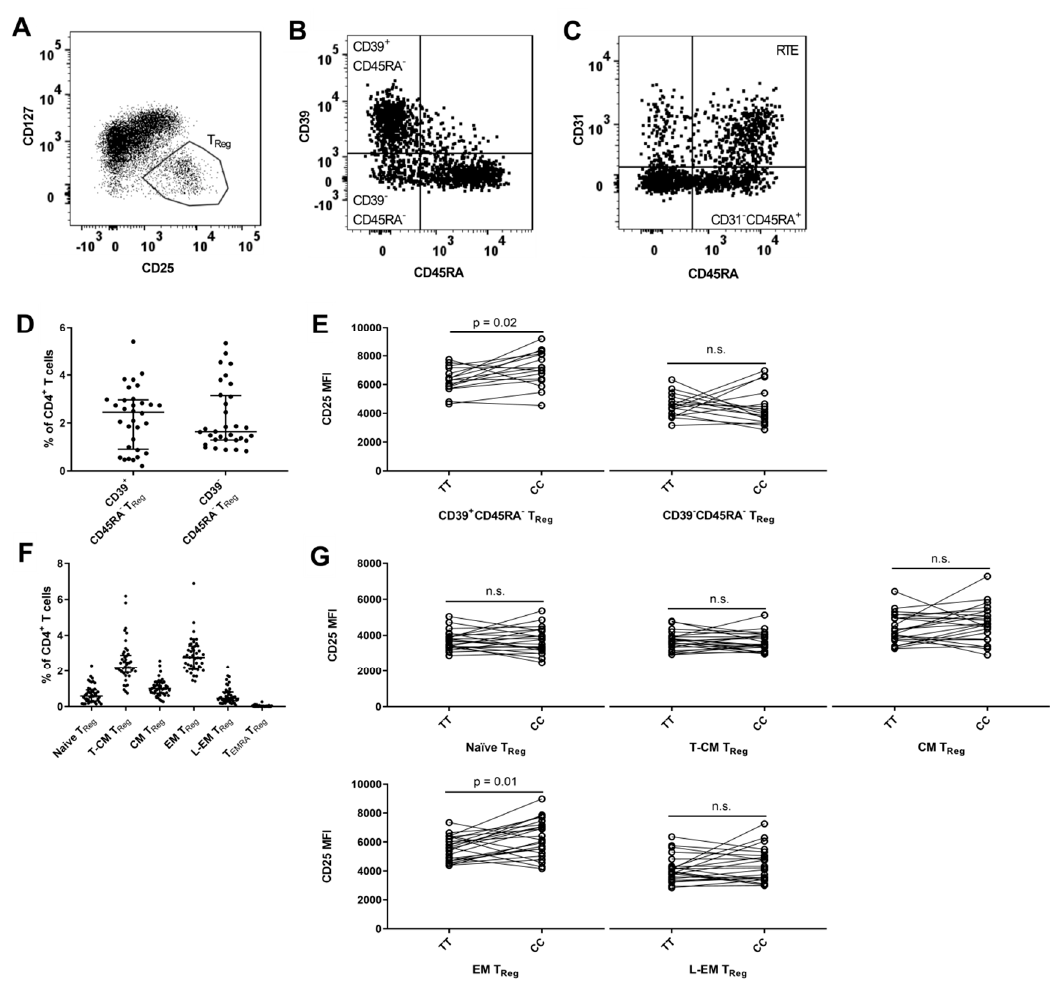
Figure 6. IL2RA genotype associations on CD4 + T Reg subsets. ( A ) Gating of T Reg cells, defined by being CD127 lo CD25 hi . ( B ) T Reg cells are gated by expression of CD39 and CD45RA in two subsets: CD39 + CD45RA − (committed T Reg cells) and CD39 − CD45RA − . ( C ) T Reg cells are gated by expression of CD31 and CD45RA in two subsets: Recent thymic emigrants (RTE; CD31 + CD45RA + ) and CD31 − CD45RA + . ( D ) Frequency of CD39 + CD45RA − and CD39 − CD45RA − T Reg in relation to CD4 + T cells. ( E ) Homozygous carriers of both MS-associated IL2RA SNPs rs2104286 and rs11256593 are defined by TT for the risk genotype and CC for the protective genotype. Di ff erences between carriers of the risk genotype TT (N = 16) and carriers of the protective genotype CC (N = 16) on surface expression of CD25 (MFI) on CD39 + CD45RA − (Paired t test, mean of di ff erence = 800.9; 95% CI = 175.2 to 1427) and CD39 − CD45RA − T Reg (Paired t test, mean of di ff erence = − 110; 95% CI = − 956.9 to 736.9) cells. ( F ) Frequency of naïve (CD45RA hi CCR7 + ), transitional central memory (T-CM) (CD45RA lo-int CCR7 + ), central memory (CM) (CD45RA − CCR7 + ), e ff ector memory (EM) (CD45RA − CCR7 − ), late e ff ector memory (L-EM) (CD45RA lo-int CCR7 + ) and T EMRA (CD45RA hi CCR7 − ) cells with a T Reg phenotype in relation to CD4 + T cells. Gating for CD4 + T cell di ff erentiation are outlined in Figure 1B. ( G ) Di ff erences between TT carriers (N = 23) and CC carriers (N = 23) on surface expression (MFI) of CD25 on T Reg naïve (Paired t test, mean of di ff erence = − 25.9; 95% CI = − 303.2 to 251.4), T-CM (Paired t test, mean of di ff erence = − 33; 95% CI = − 262.1 to 196.1), CM (Paired t test, mean of di ff erence = 278.1; 95% CI = − 149.7 to 706), EM (Paired t test, mean of di ff erence = 720.6; 95% CI = 181.5 to 1260) and L-EM (Paired t test, mean of di ff erence = 240.6; 95% CI = − 222.3 to 703.5) cells.